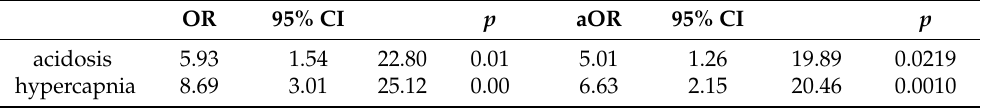
Table 2. Crude and adjusted odds ratios from logistic regression models for the relationship between capillary blood gas parameters (acidosis and hypercapnia) and an ICU transfer. OR 95% CI p aOR